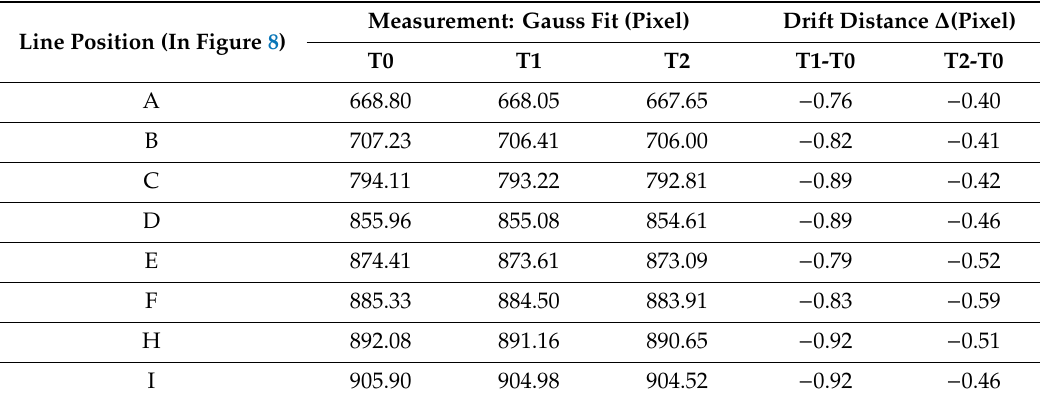
Figure 8. Spectrum shift monitoring using a mercury lamp for the prism spectrometer. The x -axis is the array number in spectrum dimension for the bottom panel, and the x -axis is the wavelength for the upper plot. There is the same y -axis (intensity) for two figures, the data of which (green lines) derives from the same test. The mercury measurements at two temperature spots are respectively plotted in green and red lines, and the spectrum drift ∆ is shown between two tests, the value of which is only amplified to illustrate the phenomenon. The eight characteristic spectrum lines (A, B, C, D, E, F, G, H, I), which are labelled in the bottom panel, are evenly distributed across the wavelength range from 400 to 1000 nm. The light from the lamp passes through the parchment paper, and the lens of fore-telescope system is fully filled with light. The specific values between intensity from the di ff erent spectrum lines are di ff erent in di ff erent test conditions. Table 2. Spectrum shift monitoring using a mercury